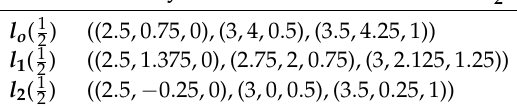
Table 3. Fuzzy control